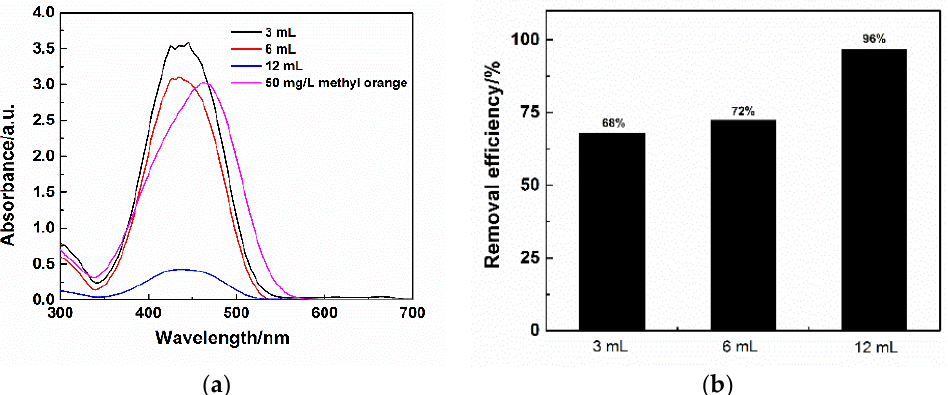
Figure 13. ( a ) UV visible absorption spectra of filtrates filtered by varied volumes of flexible MSQ aerogels without surface modification and 50 mg · L − 1 methyl orange standard solution; ( b ) Removal efficiency of varied volumes’ flexible MSQ aerogels without surface modification.